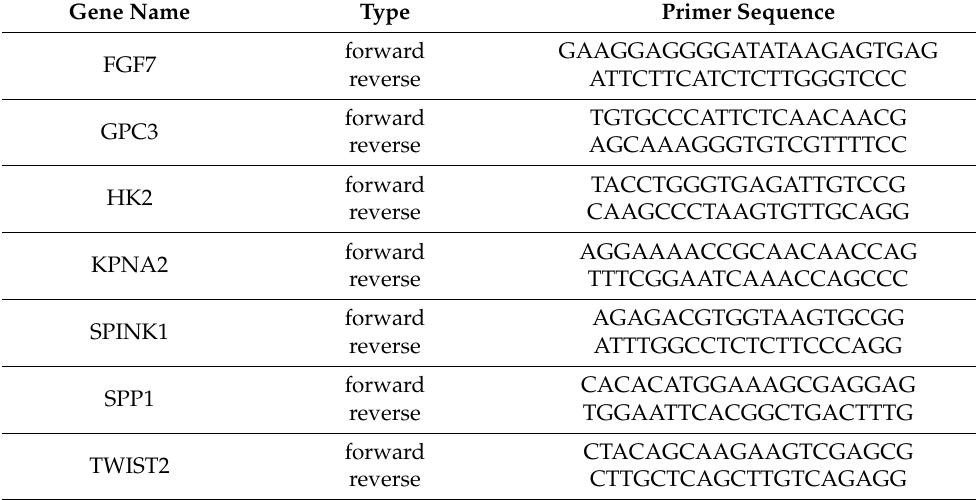
Table 2. Primer for